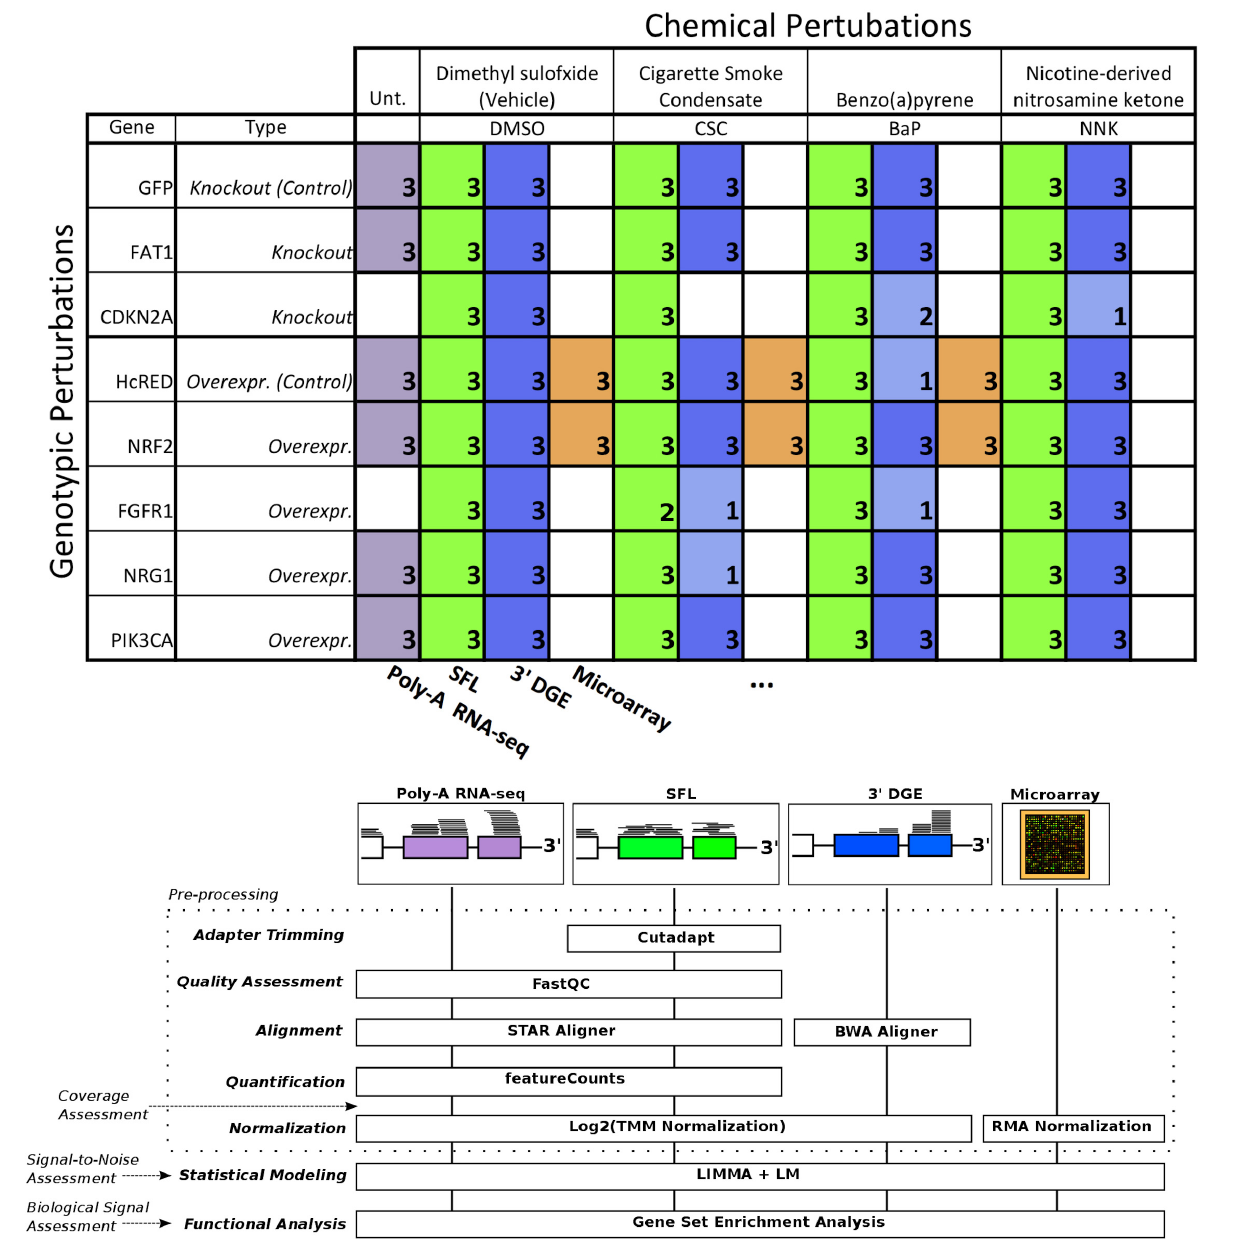
Labeling and Controls Kit protocol (Thermo Fisher